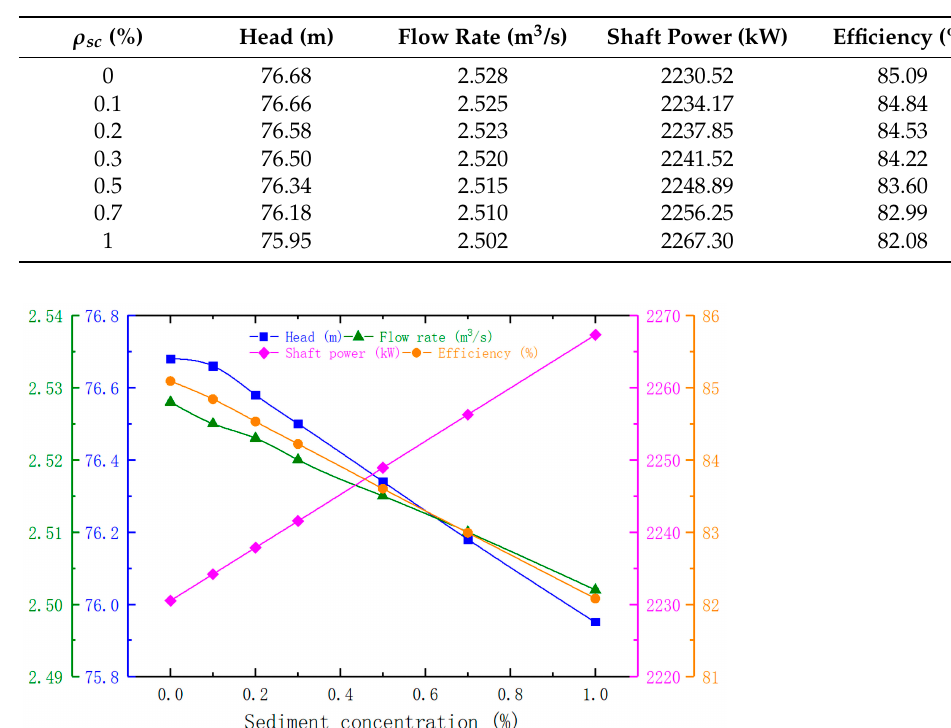
Table 3. Performance parameters of centrifugal pump with different sediment concentrations at design flow rate Q .